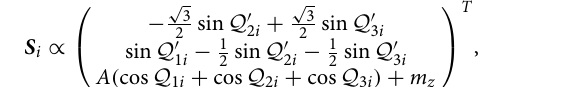
Figure 3. Mechanism of the topological transition for Ŵ (cid:31) 0.2 . ( a ) H dependence of the phase ψ obtained from the simulated annealing (SA) and variational calculation (VC) in the model in Eq. (6) at Ŵ pictures of the constitute waves in each SkX are shown in the inset. ( b ) ψ dependences of energies from different contributions, E RKKY , E Ŵ , and E Zeeman in the unit of J , Ŵ , and H , respectively, for A 4 π/ 3 , φ 2 2 π/ 3 , and φ 3 1 . The vertical dashed line represents the boundary π in Eq. (7) with φ 1 S i = = = | | = 1 and between the SkXs with n sk =